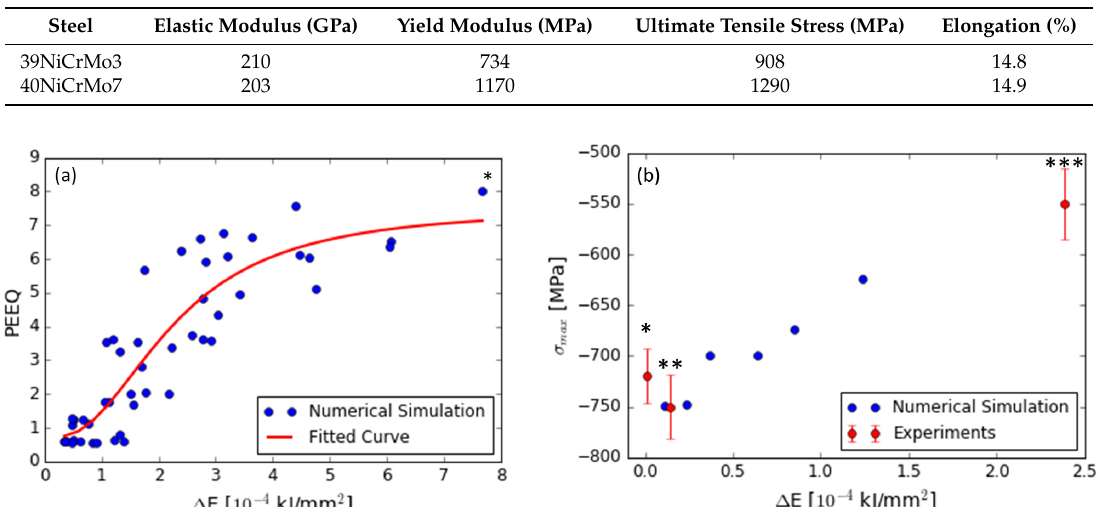
Table 1. General mechanical properties of 39NiCrMo3 and 40NiCrMo7 steel.